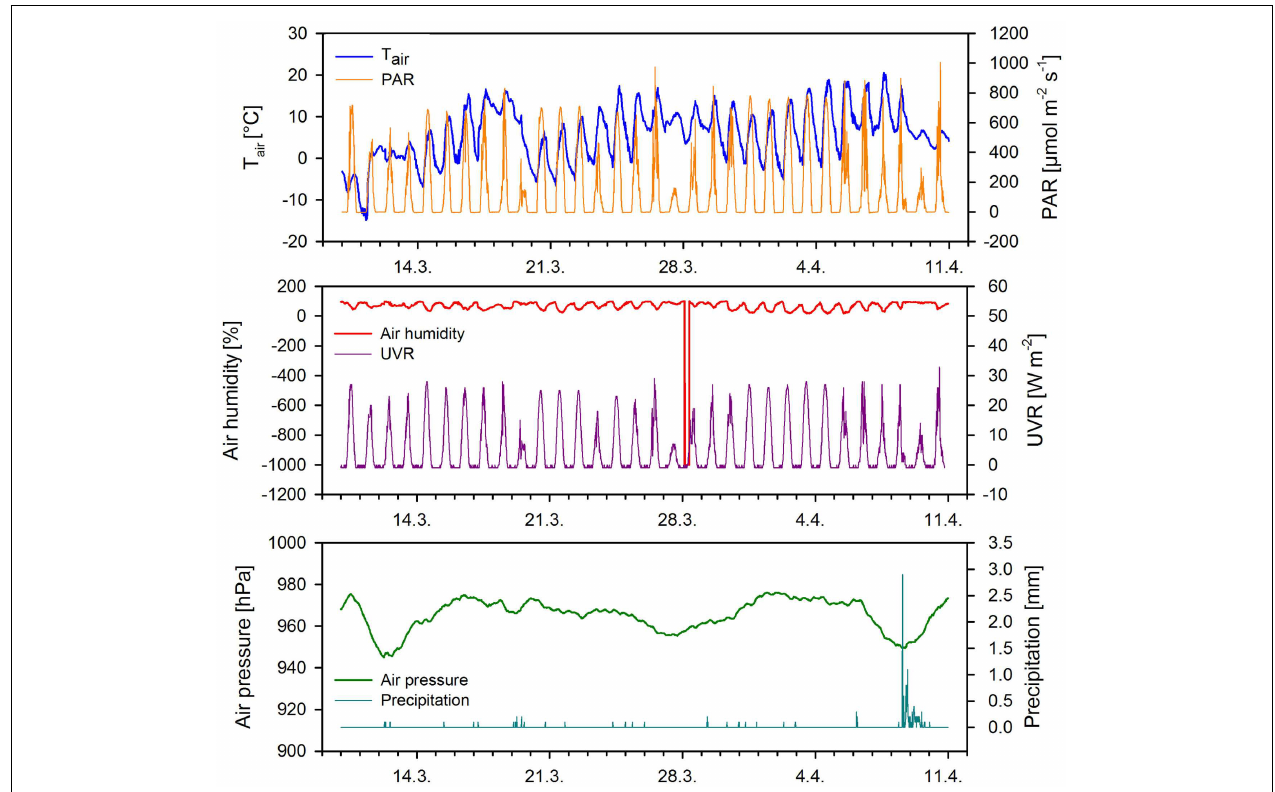
FIGURE 4 | Meteorological conditions during the out-door cultivation measured at 15-min intervals . Abbreviations: T air , air temperature; PAR, photosynthetically active radiation; UVR, ultraviolet